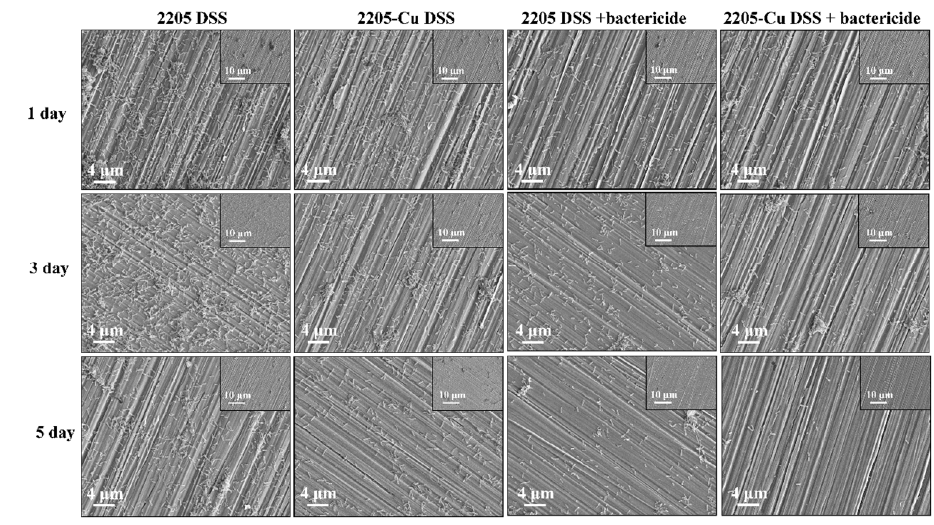
Figure 4. SEM biofilm images on coupons of 2205 DSS and 2205-Cu DSS after the 1-, 3-, and 5-day incubations.